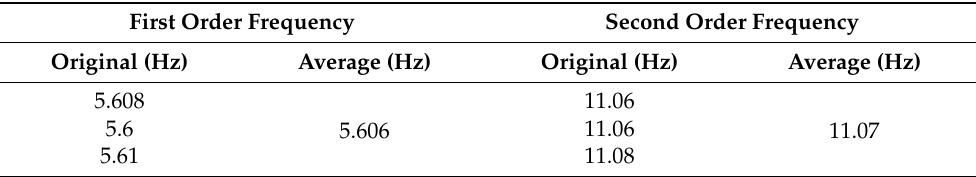
Figure 3. Time history diagrams and frequency domain diagrams derived from acceleration samplings of Z axis by acceleration sensor. Table 3. Frequencies sampled by the acceleration sensor and their average